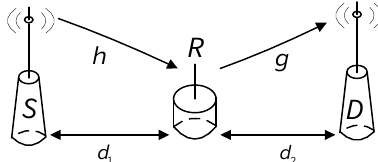
Figure 1. Simultaneous wireless information and power transfer (SWIPT) wireless cooperative